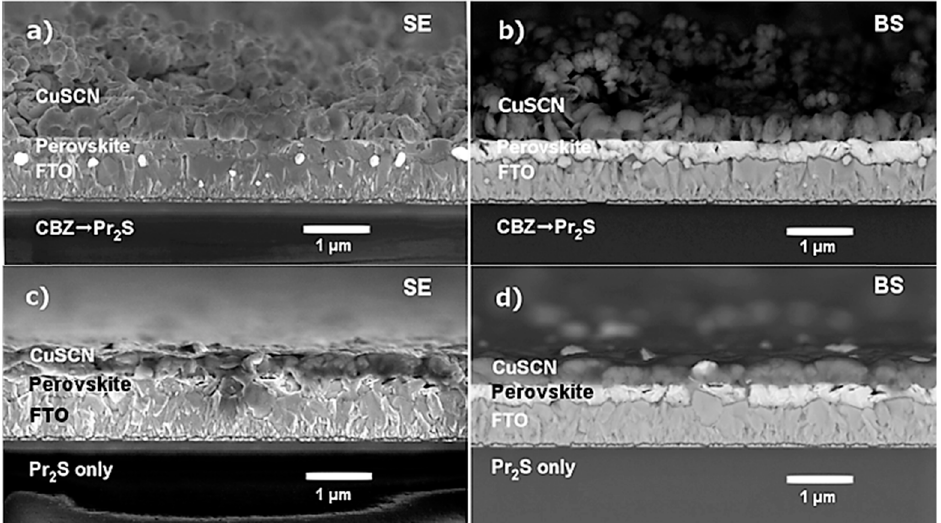
Figure 4. Scanning Electron Microscopy (SEM) cross-sectional images of FTO/c-TiO 2 /CH 3 NH 3 PbI 3 /CuSCN assemblies that were fabricated by doctor blading a solution of CuSCN in dipropyl sulfide ( a , b ) on a chlorobenzene pre-wetted perovskite layer (CBZ → Pr 2 S) and ( c , d ) on a dry perovskite layer (Pr 2 S only). SE: secondary electron images; BS: backscattered electron images. Reproduced with permission from Reference [49]. Elsevier 2017.